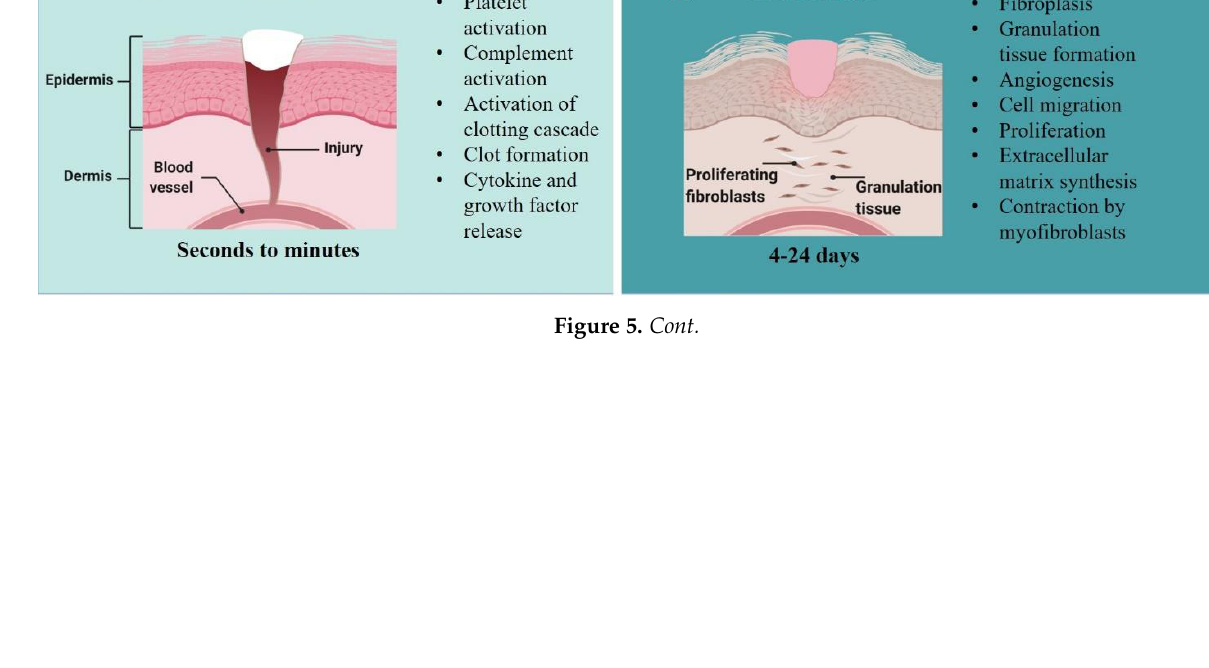
Figure 5. Phases of wound healing . The main events implicated during wound healing are hemostasis, inflammation, proliferation, and remodeling. (1) Hemostasis is the process of blood clotting and is the shortest phase in wound healing, lasting for only a few minutes. (2) The inflammatory phase comprises of blood coagulation, phagocytosis, removal of foreign bodies, and recruitment of growth factors and anti-inflammatory cells at the site of injury. (3) The proliferation phase encompasses fibroplasia, angiogenesis and cell migration, cell recruitment, re-epithelialization, and wound contrac- tion. (4) Finally, in the remodeling phase, type I collagen replaces type III collagen in the wound site. Eventually, scar formation occurs through apoptosis. Table 6. Summary of major growth factors families and their applications in injury healing. Growth Factor